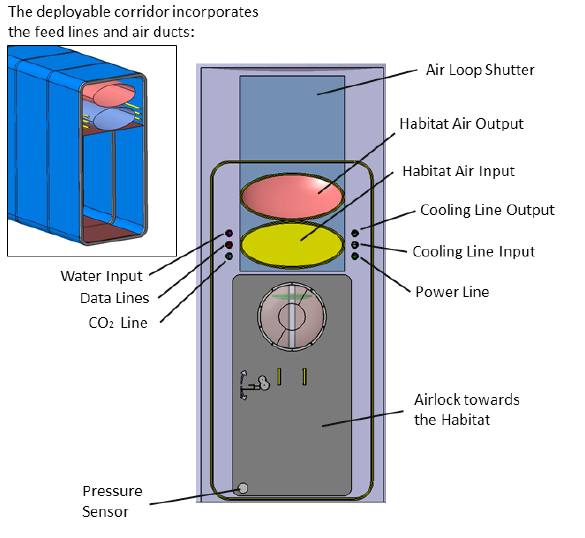
Figure 17: Dedicated exchange